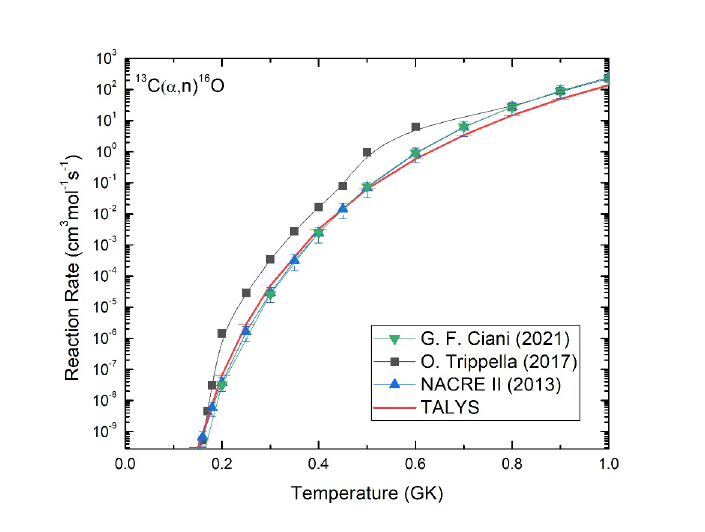
Figure 2. Theoretically calculated thermonuclear reaction rate for 13 C( α , n) 16 O reaction along with experimental data and NACRE